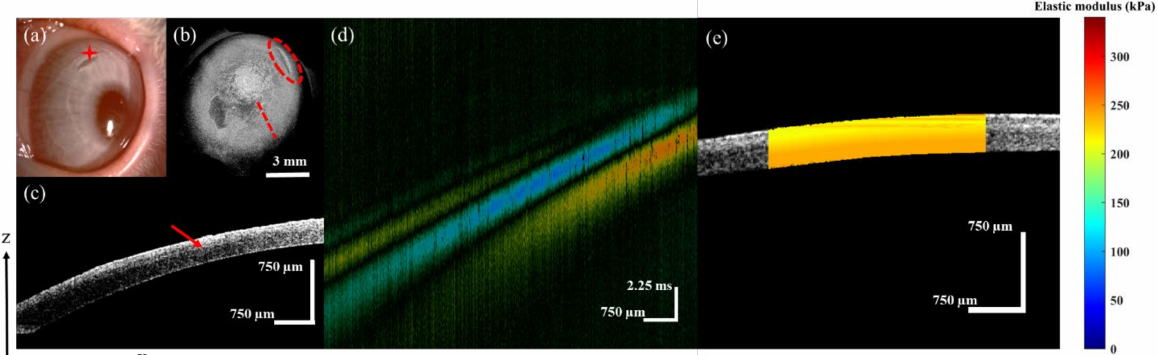
Figure 6. The SMILE surgery corneal images, ( a ) is the SMILE surgery surface morphology, ( b ) is the 3D reconstruction structure, ( c ) is the 2D tomography, ( d ) is the spatial-temporal displacement diagram of the Lamb wave, and ( e ) is depth-resolved elastography result of the